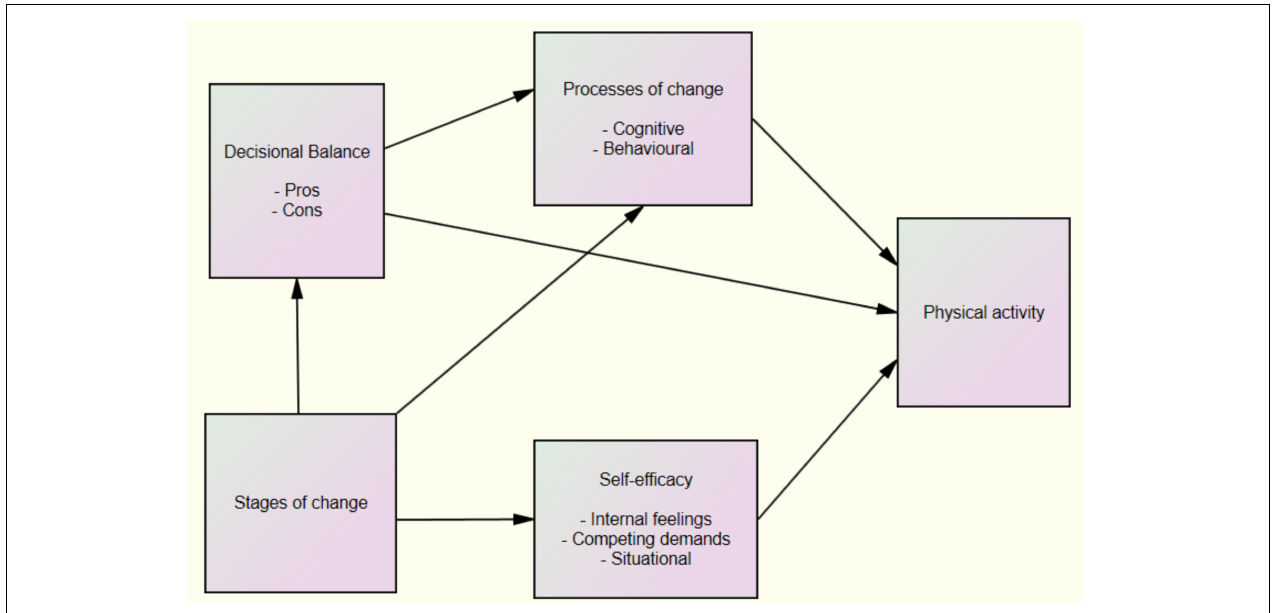
FIGURE 1 | Hypothesized model for explaining undergraduate students’ physical activity